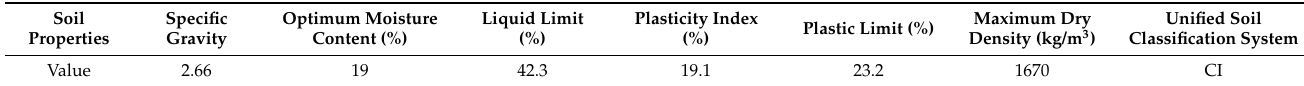
Table 1. Clayey soil